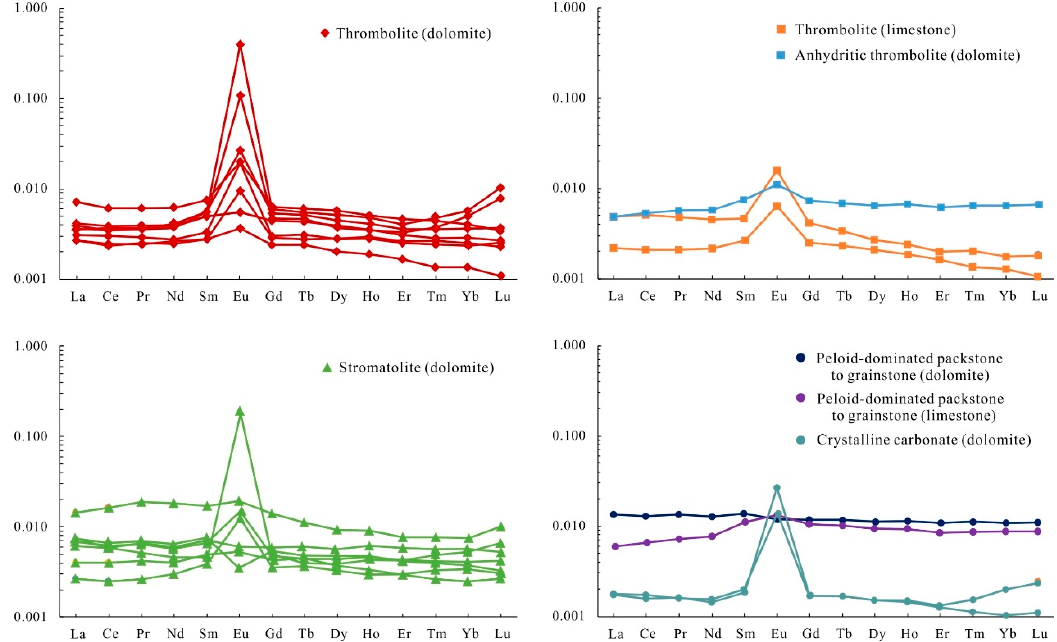
Figure 8. Rare earth elements (REE) pattern of different lithofacies in the Leikoupo Formation. The values of rare earth elements are normalized to the Post-Archen Australian Shale (PAAS).